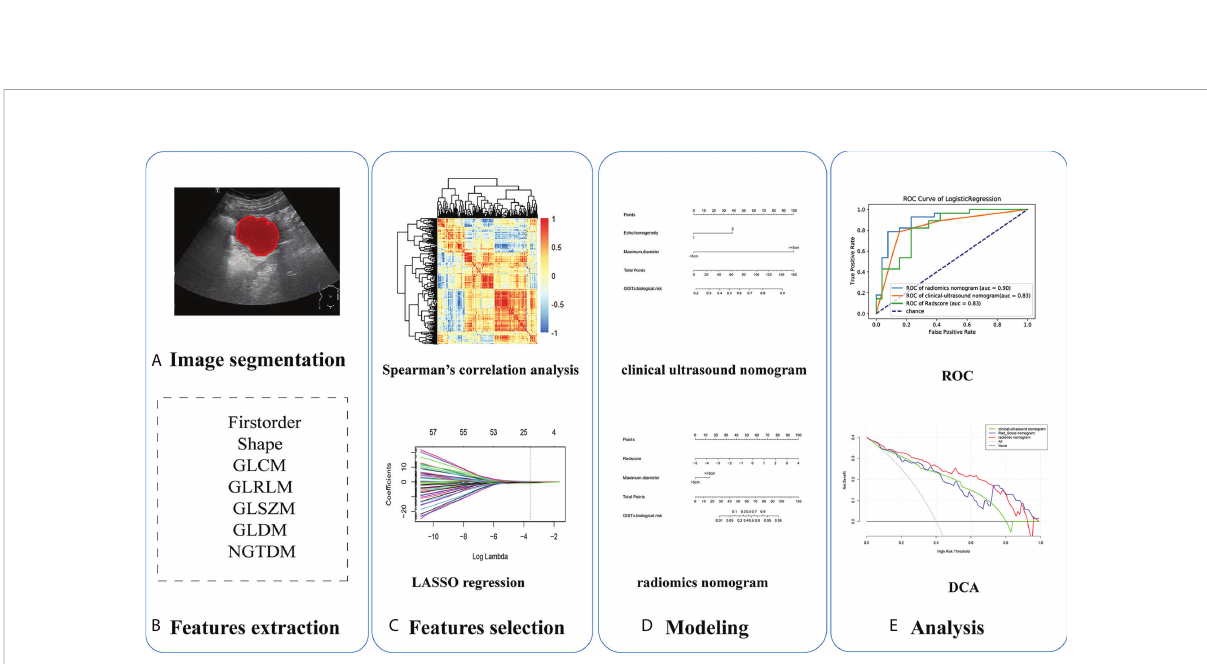
FIGURE 2 Five steps of radiomics research: (A) ultrasound imaging and tumor segmentation, (B) image processing and feature extraction, (C) feature selection, (D) modeling, and (E) performance of models.